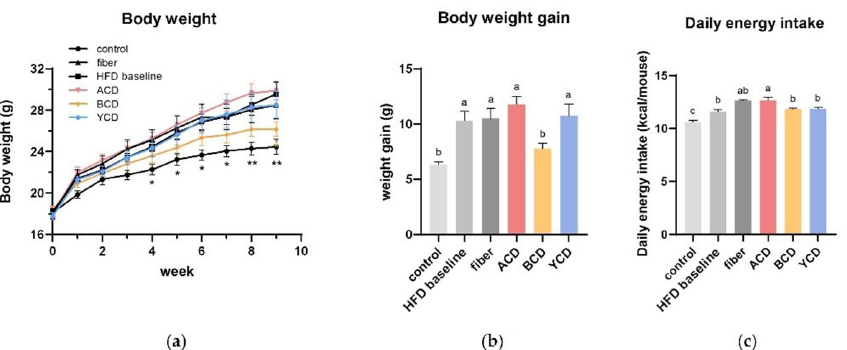
Figure 1. β -CD supplementation inhibited excess weight gain in C57BL/6J mice fed a high-fat diet independent of energy intake. ( a ) Changes in body weight from week 0 to week 9; ( b ) body weight gain at week 9 compared to week 0; ( c ) daily energy intake during the experimental period. n = 6. Control, low-fat diet; HFD baseline, high-fat diet without cellulose; fiber, high-fat diet; ACD, high-fat diet that replaced α -CD with cellulose; BCD, high-fat diet that replaced β -CD with cellulose; YCD, high-fat diet that replaced γ -CD with cellulose. Data are expressed as means ± SEM. * p < 0.05, ** p < 0.01 compared to the HFD baseline group (ANOVA). Values not sharing a common superscript differ significantly among groups ( p < 0.05, ANOVA).